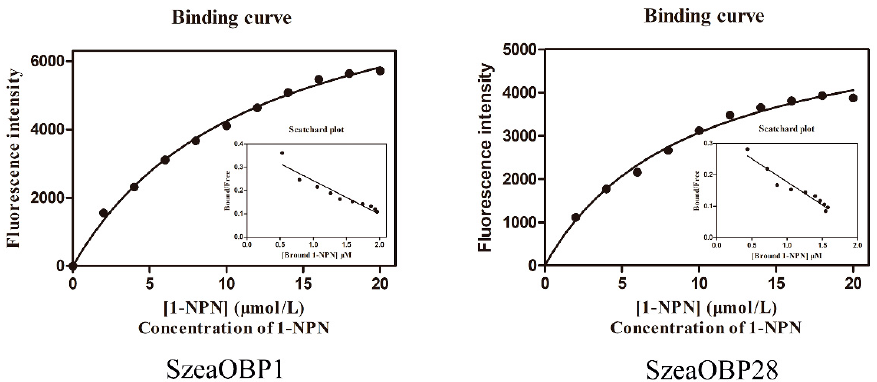
Figure 6. Binding curves and Scatchard plots of the fluorescence probe 1-NPN with SzeaOBP1 and SzeaOBP28. The binding curves and corresponding Scatchard plots indicate that the binding constant of the SzeaOBP1/1-NPN complex was 8.590 μ M, and that of the SzeaOBP28/1-NPN complex was 7.214 μ M.